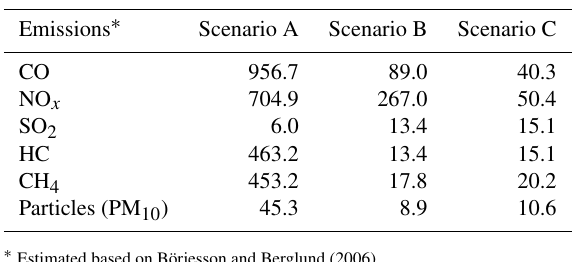
Table 2. End-use emissions of biogas in different scenarios (g per 1tonne of dry sludge).